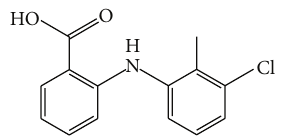
Figure 1: Structure of tolfenamic